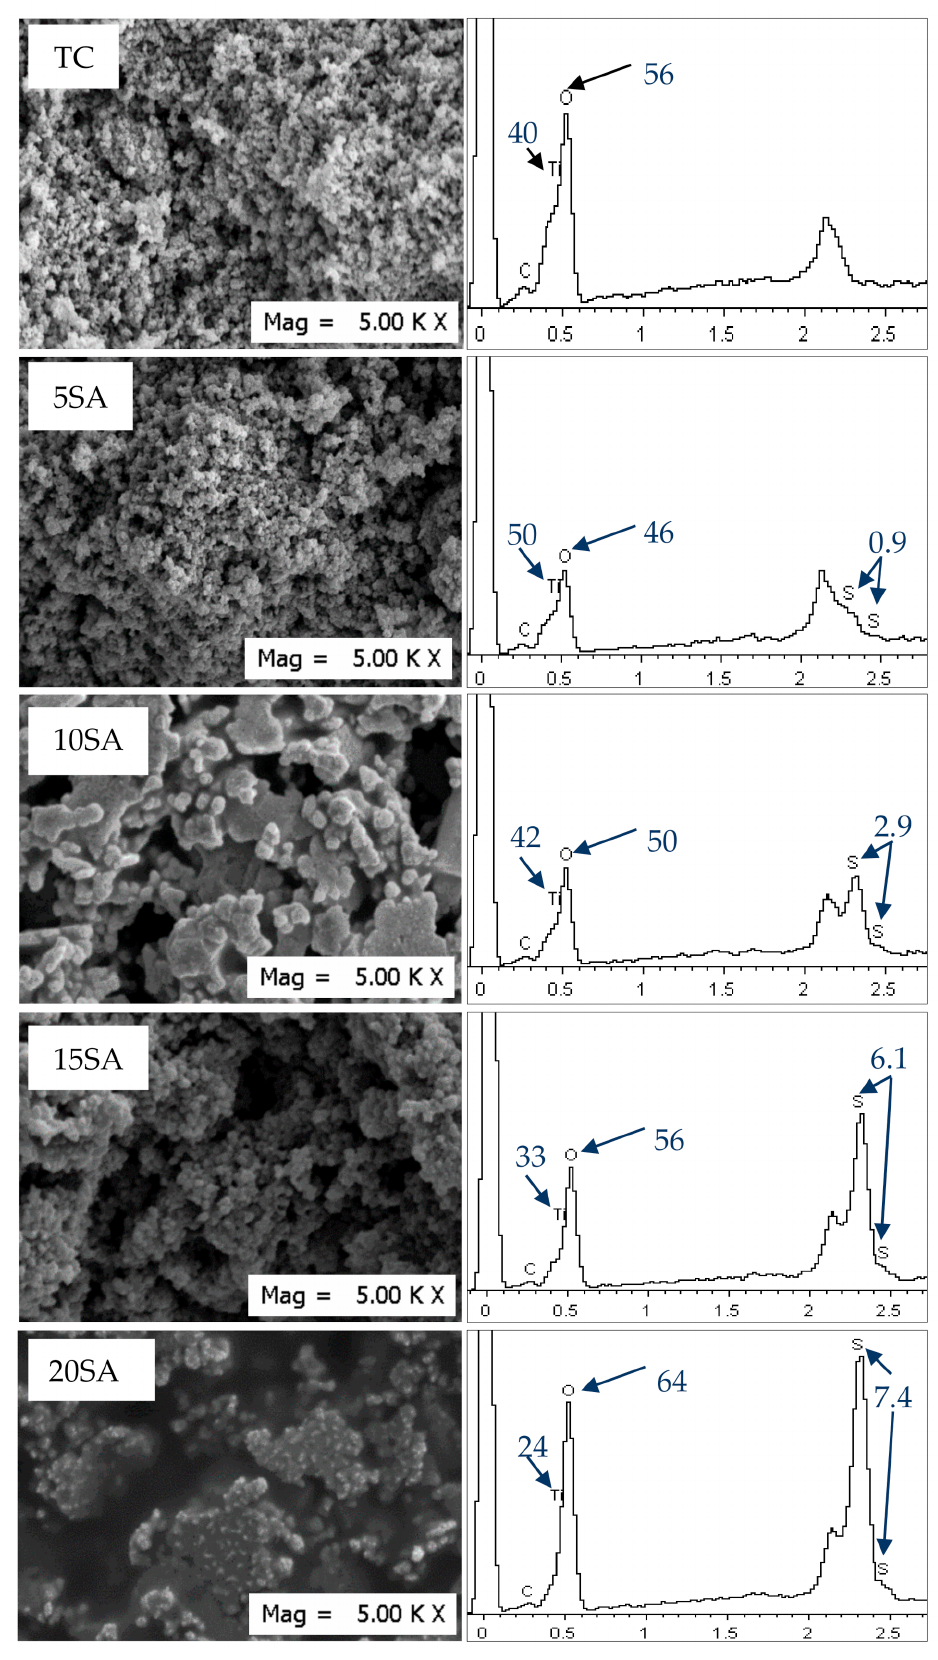
Figure 6. SEM micrograph of sulphated and uninsulated titania